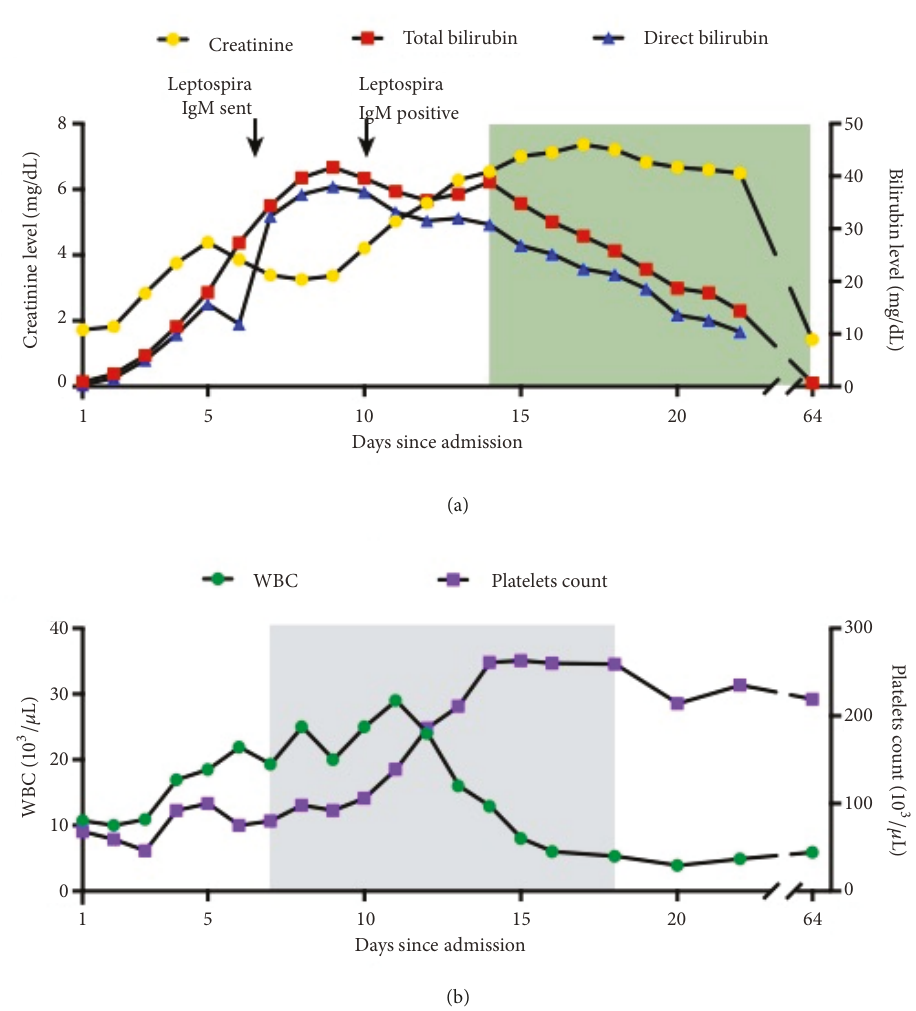
Figure 1: Multiorgan failure and response to treatments in patient with leptospirosis. (a) Creatinine, total bilirubin, and direct bilirubin levels during and after hospitalization. Shaded green area represents duration of cholestyramine and ursodiol treatment for bile cast nephropathy. (b) White-blood cell count (WBC) and platelet count during and after hospitalization. Shaded grey area represents duration of doxycycline